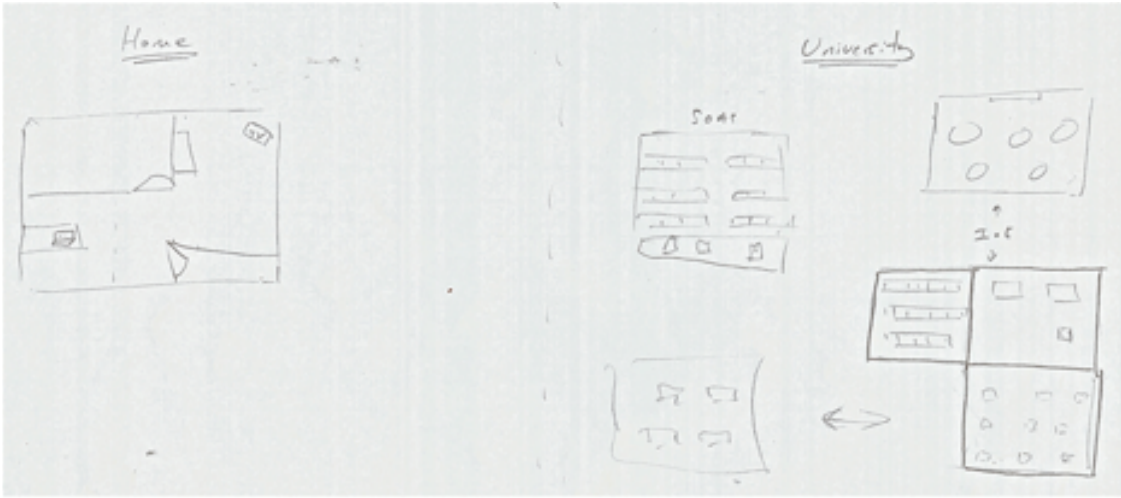
Figure 2: Juan’s ‘map’ of practice